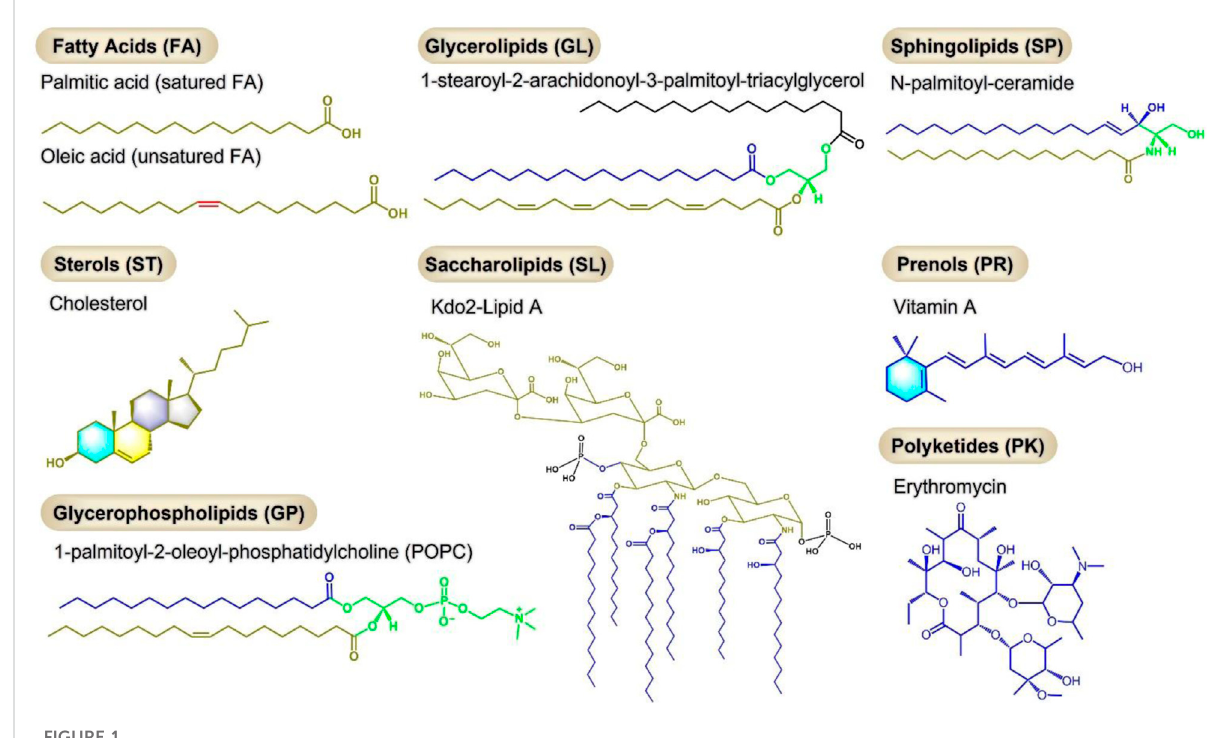
FIGURE 1 Eight types of lipids, each with a representative